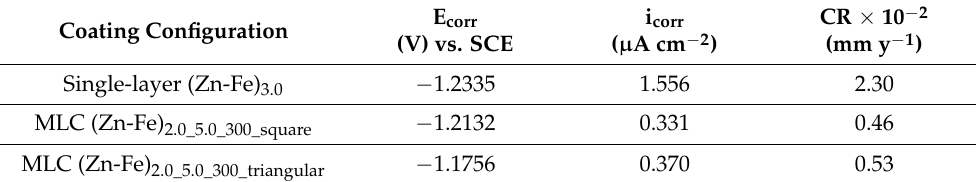
Table 5. The corrosion rate of the single-layer and multilayer alloy coatings.